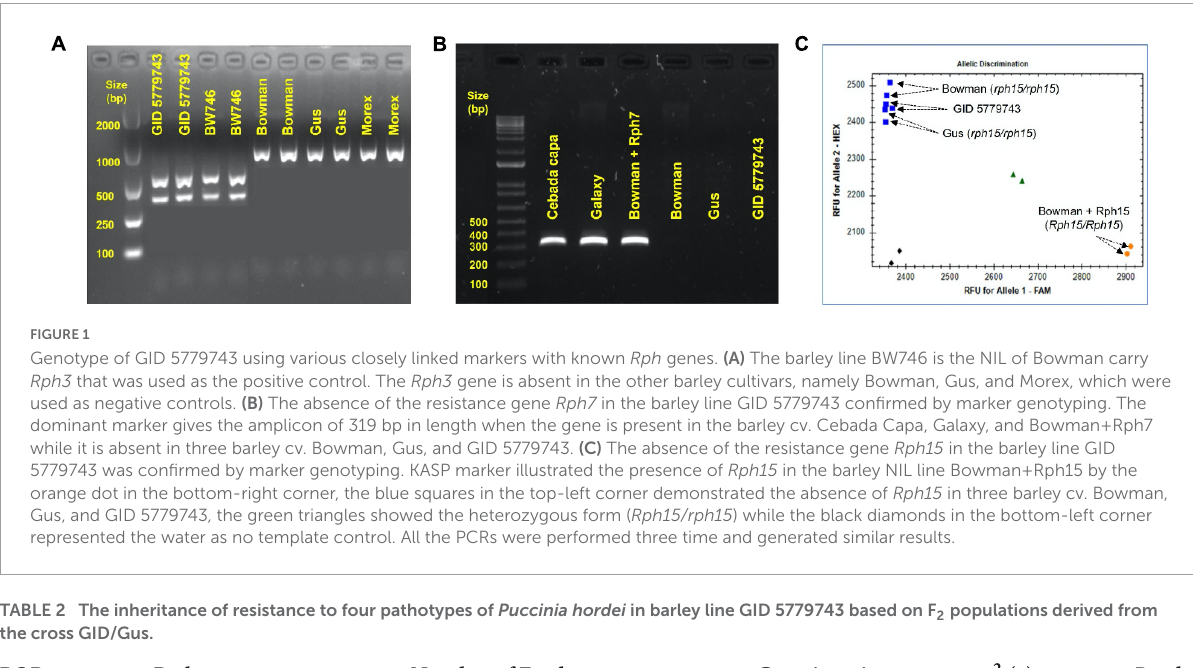
TABLE 2 The inheritance of resistance to four pathotypes of Puccinia hordei in barley line GID 5779743 based on F 2 populations derived from the cross GID/Gus. POP Pathotype Number of F 2 plants Genetic ratio χ 2 (a) P -value Resistant Susceptible